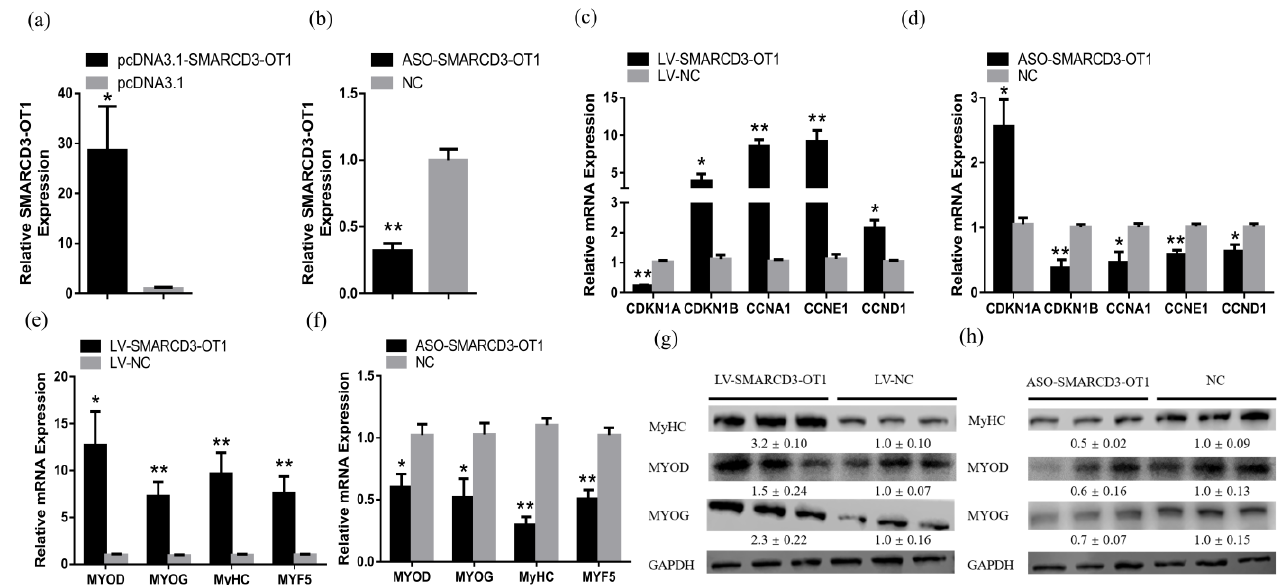
Figure 7. SMARCD3-OT1 regulates the CDKN1A pathway and MYOD pathway in vivo. ( a ) Relative SMARCD3-OT1 expression in gastrocnemius muscle after infection with SMARCD3-OT1 -expressing lentivirus (LV- SMARCD3-OT1 ) or negative control (LV-NC) ( n = 6). ( b ) Relative SMARCD3-OT1 expression in gastrocnemius muscle after infection with modified ASO specific to SMARCD3-OT1 (ASO- SMARCD3-OT1 ) or negative control (NC) ( n = 6). ( c , d ) Relative mRNA levels of several cell cycle genes after overexpression or knockdown of SMARCD3-OT1 in vivo ( n = 6). ( e , f ) Relative mRNA levels of several myogenesis marker genes after overexpression or knockdown of SMARCD3-OT1 in vivo ( n = 6). ( g , h ) Relative protein levels of several myogenesis marker genes after overexpression or knockdown of SMARCD3-OT1 in vivo ( n = 3). The numbers shown below the bands are folds of band intensities relative to control. Band intensities were quantified by ImageJ and normalized to GAPDH. Data are expressed as a fold change relative to the control. Results are shown as mean ± SEM. Statistical significances of differences between means were assessed using a paired sample t test. * p < 0.05, ** p < 0.01.